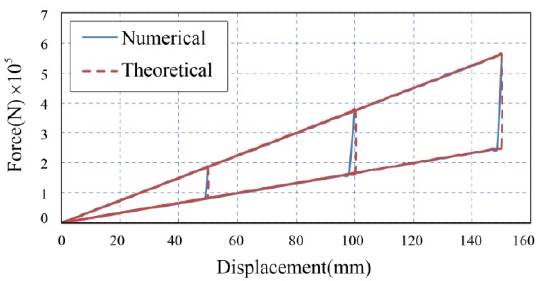
Figure 4. The theoretical constitutive model compared to that of the numerical experiment of LFD.